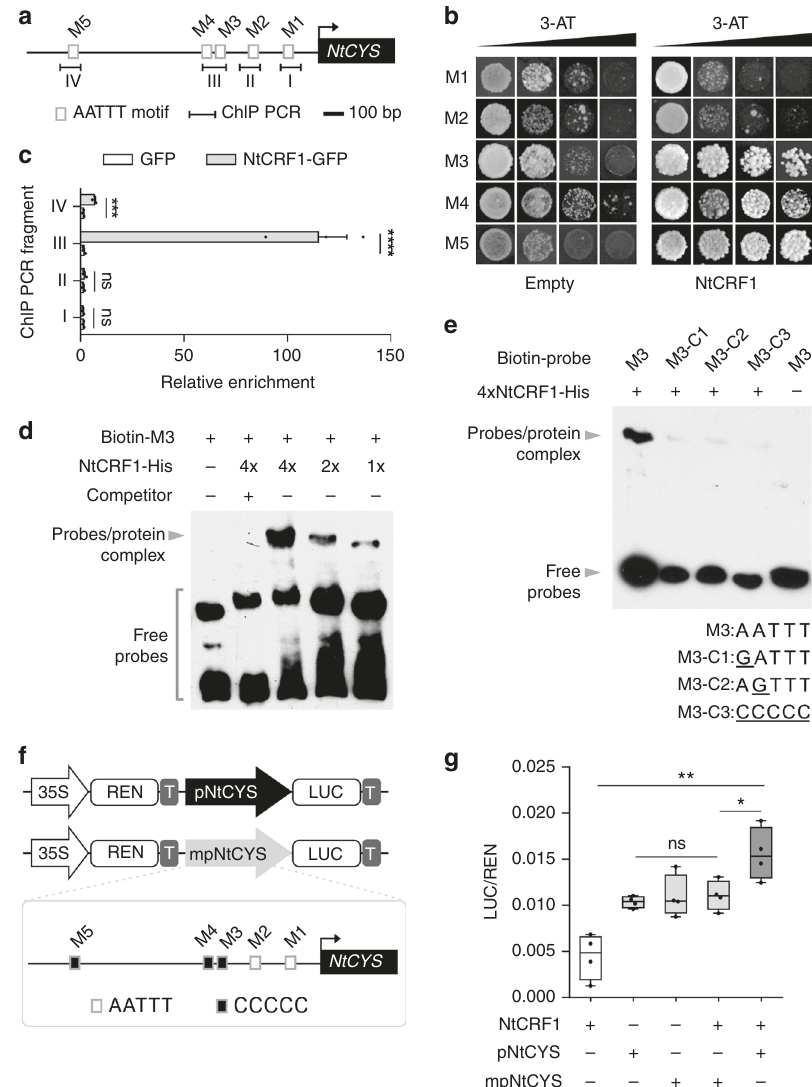
Fig. 1 NtCRF1 binds to the NtCYS promoter. a Distribution of AATTT motifs (M) in the promoter region ( − 1.4 kb) of NtCYS . Fragments I ( − 189 to − 83 bp), II ( − 396 to − 296 bp), III ( − 609 to − 476 bp), and IV ( − 1300 to − 1211 bp) were subjected to ChIP-qPCR. b Yeast one-hybrid assay of the interaction of NtCRF1 with M3-M5. Empty pGAD424: control. c ChIP-qPCR analysis of the enrichment of NtCRF1 with the four promoter regions. pNtCRF1::GFP , control. Error bars represent the standard error (SE) of three biological replicates. d Binding of recombinant NtCRF1 to M3 was outcompeted by puri fi ed NtCRF1 (2 and 4×) and biotin-labeled DNA fragments. e Top: Binding of NtCRF1 to M3 mutants was reduced; Bottom: The sequences of M3 and the three mutant motifs. f Structure of the pNtCYS -driven and mpNtCYS (mutant promoter)-driven Dual-Luc reporter gene. 35S promoter (white arrow), pNtCYS (black arrow), mpNtCYS (gray arrow), Renilla luciferase (REN), fi re fl y luciferase (LUC) and terminator (T) are indicated. Box: The mutant motifs of mpNtCYS . g Relative reporter activity (LUC/REN) in tobacco protoplasts. The relative LUC activity was normalized to the REN activity (LUC/REN, n = 4). (Student ’ s t - test; ns, P > 0.05; * P < 0.05; ** P < 0.01; *** P < 0.001; **** P < 0.0001). The source data of the uncropped immunoblots are provided in the Source Data fi